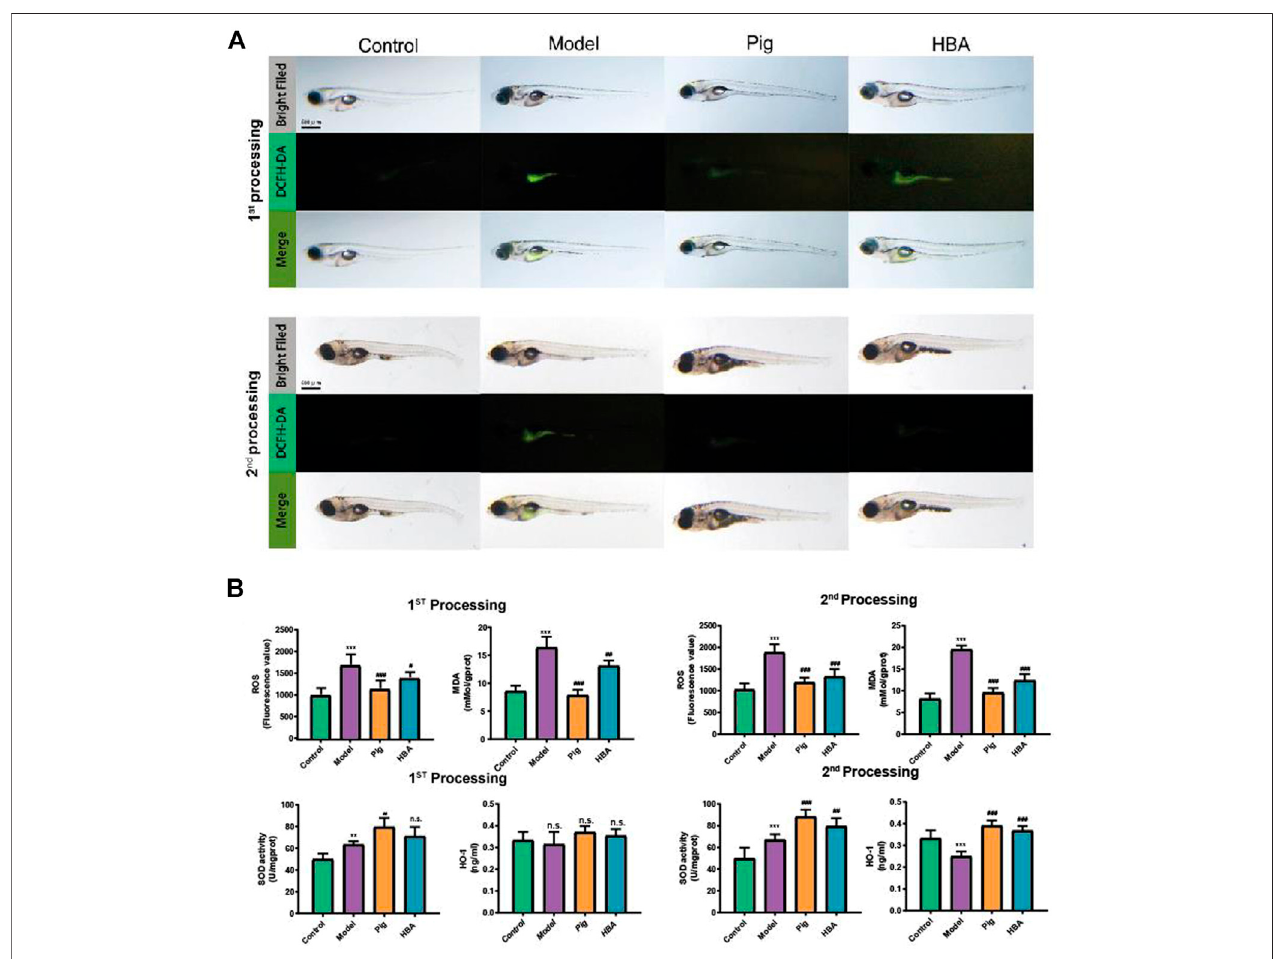
FIGURE3| EffectofHBAinoxidativestressonHCD-Induced LarvalZebra fi shModelintwoprocesses. (A) TheROSproduction showedin fl uorescenceimageby DCFH-DAstainingandmerged withalight fi eldimage. (B) TheROS(Fluorescencevalue)and MDAconcentrationofeachtreatedlarvalzebra fi shgroup;Theantioxidase SOD (U/gprot) and HO-1 level (ng/ml) of each treated larval zebra fi sh group. Bars indicate means ± SD. n. s. indicate no signi fi cant; ** p < 0.01*** p < 0.001 represent comparedwiththecontrol;# p < 0.05,## p < 0.01, ### p < 0.001 represent comparedwithModel. p < 0.05 wasconsidered asstatistically signi fi cantcalculatedby One-way ANOVA followed by Tukey ’ s test ( n (cid:1) 3, n indicates the replicates of the experiment).